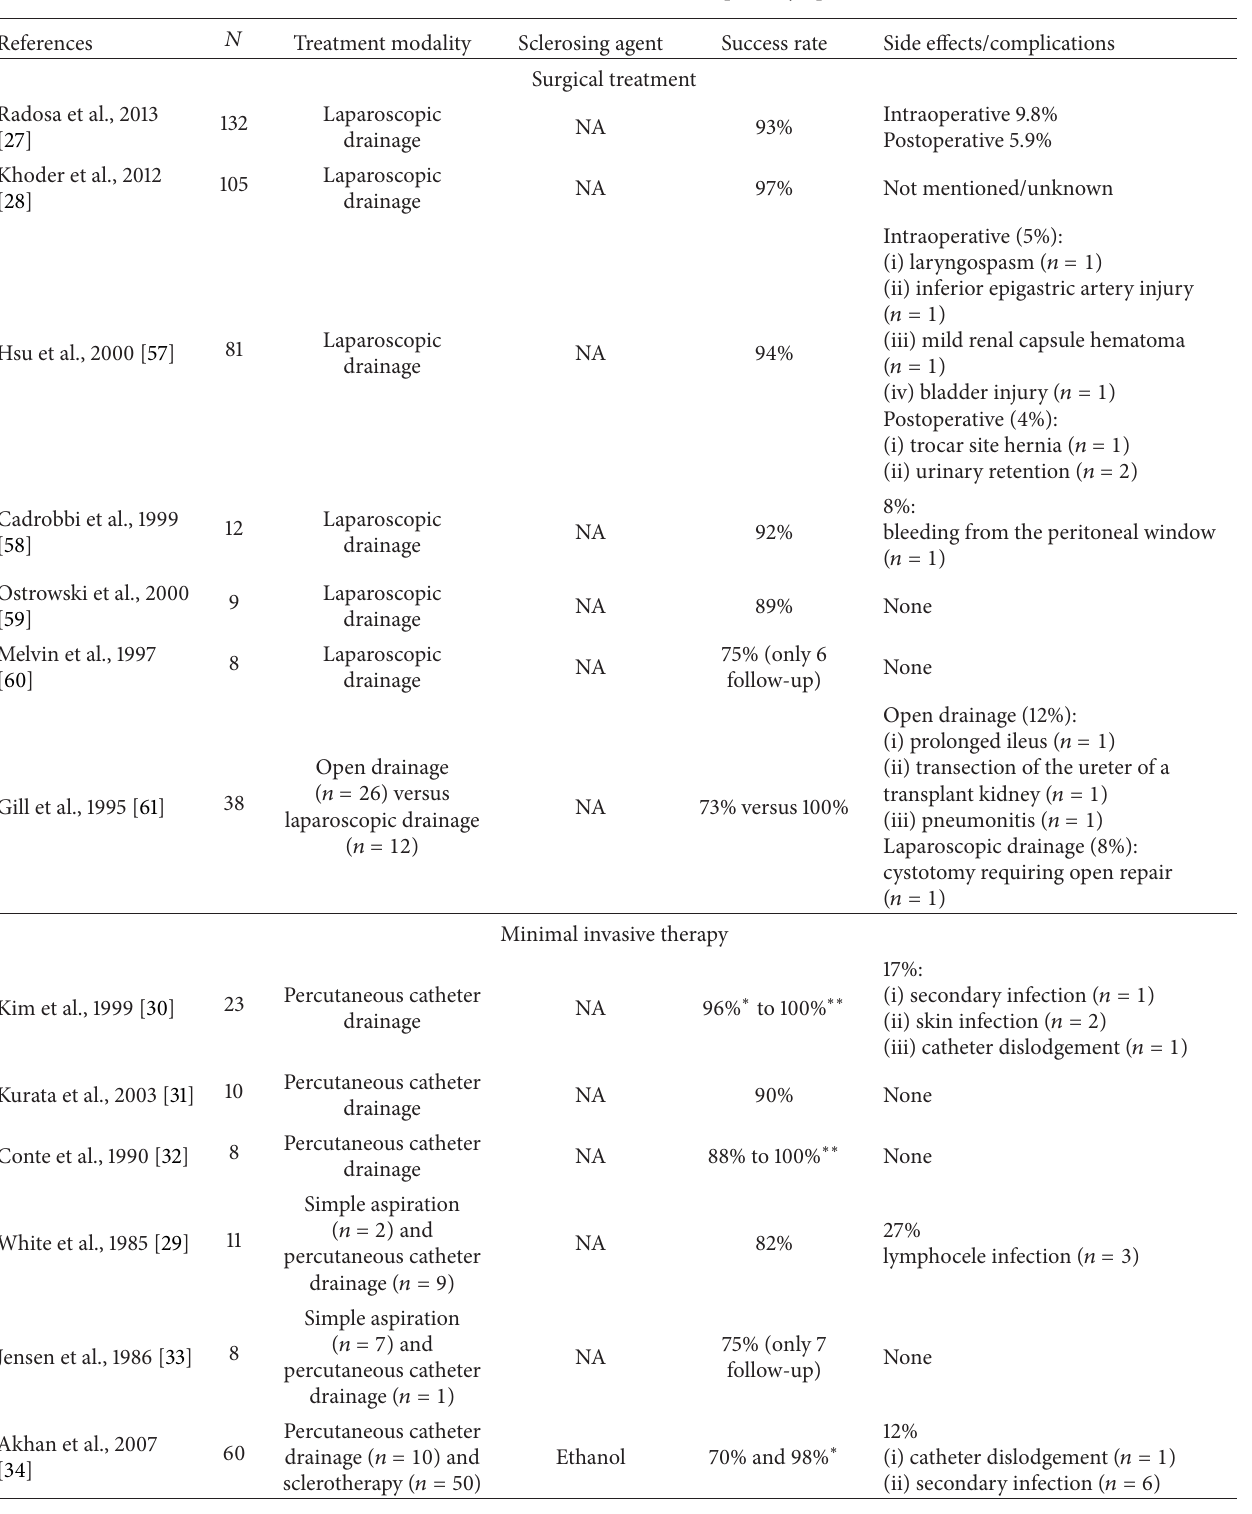
Table 1: Studies in treatment modalities for pelvic